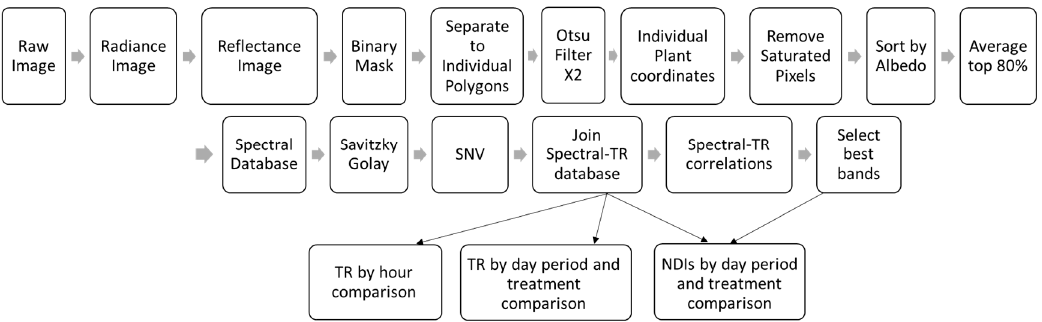
Figure 4. A flow chart summarizing the processing steps of an individual hourly image into 72 plant mean spectra.